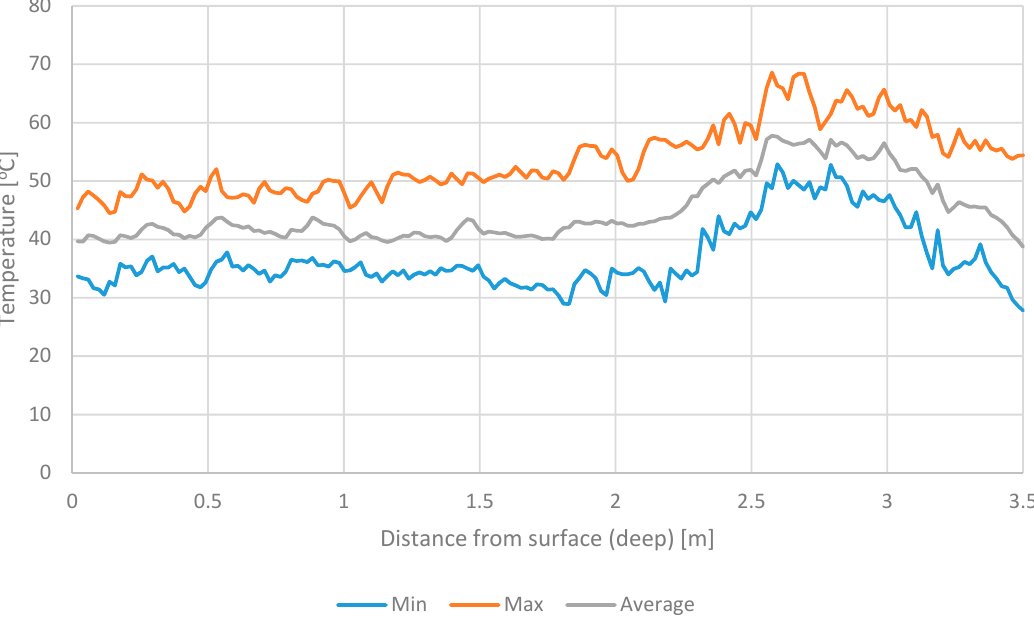
Figure 2. The temperature of an undersize fraction of municipal solid waste (UFMSW) at different depths.